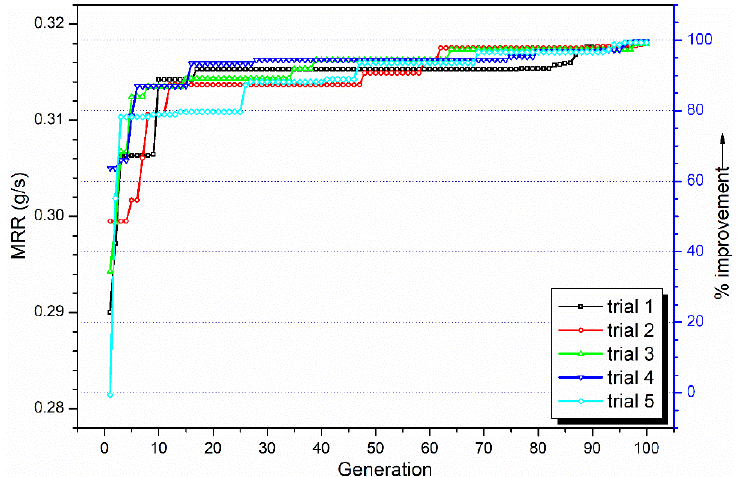
Figure 7. Convergence of Coevolutionary Host-Parasite (CHP) across 100 generations (5 independent trials shown).